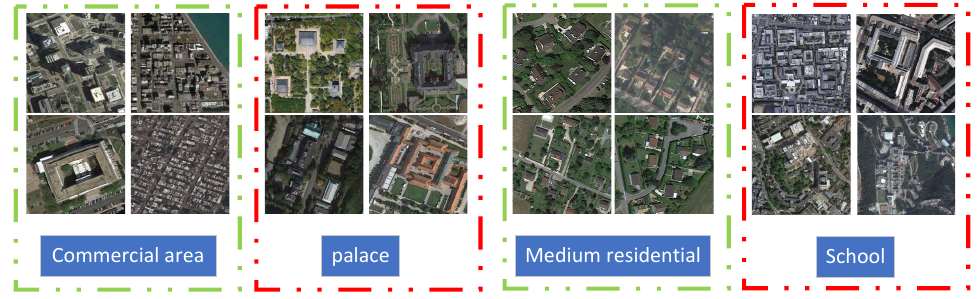
Figure 11. Sample images of some categories in NWPU-TESISC45 and AID